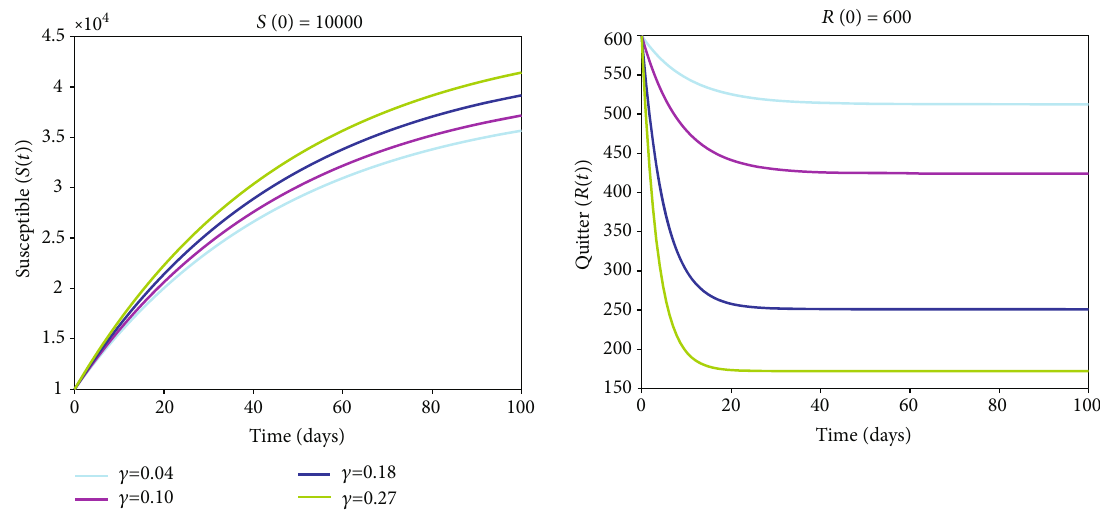
Figure 7: Susceptible and quitter population with varying the rate at which R ð t Þ becomes S ð t Þ ,